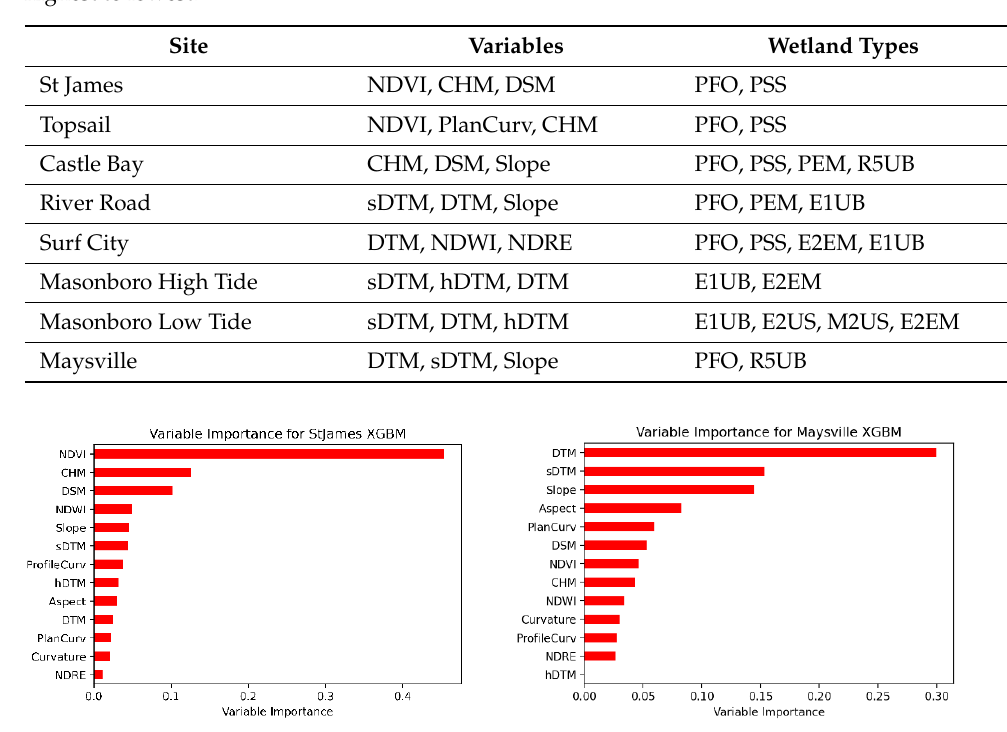
tree, with RGB color values. The blue pixels represent the CHM raster layer, the green layer represents DTM, and the red raster layer represents the NDVI values of the AOI. In Figure 5, the variable importance indicates that NDVI is the highest determinant for the St. James site. The graph on the right is the graphical representation of the XGBM classification map for the St. James site, where the green pixels represent wetlands, and the brown pixels represent non-wetlands.